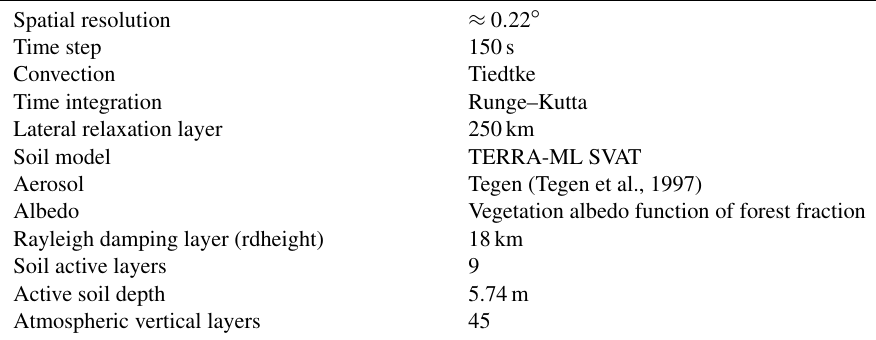
Table 1. General description of model setup of the reference simulation. Spatial